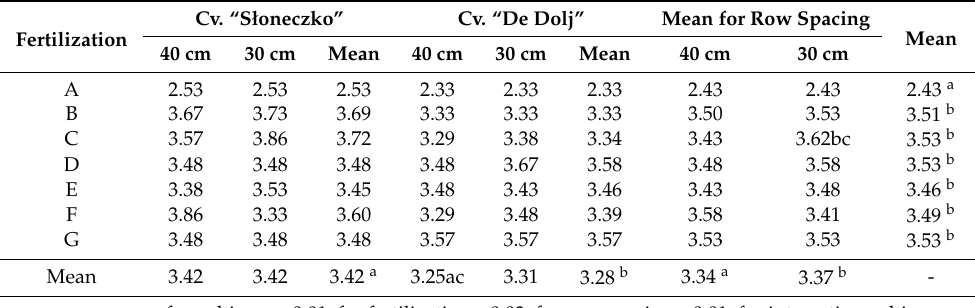
for cultivars—0.01; for fertilization—0.03; for row spacing—0.01; for interaction cultivar × row spacing—0.02; for interaction cultivar × fertilization—0.04; for interaction row